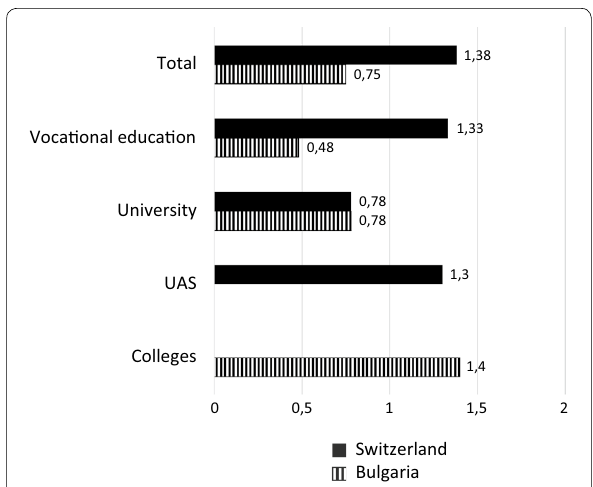
Fig. 1 Linkage strength between education and early employment, by educational sector (Mutual Information Index) (Source: Own